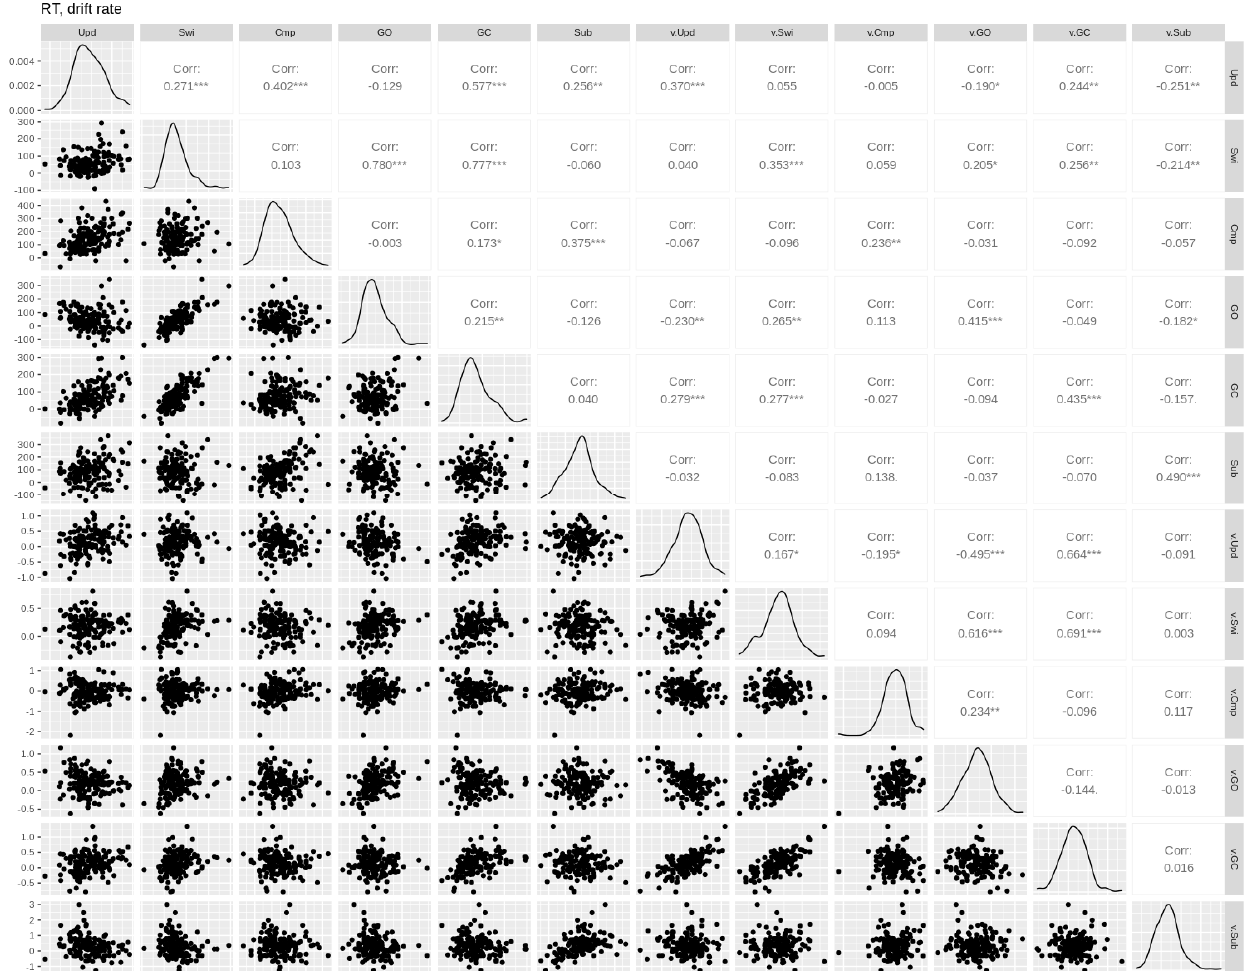
Figure A3. Pairwise Pearson correlations between drift rate and RT cost effects. Empirical effects are shown in the first six columns. Parameter effects are shown in the last six columns (prefixed with the parameter name). Upd = updating, Swi = switching, Cmp = comparison, GO = gate opening, GC = gate closing, Sub = substitution. Asterisks *, **, and *** denote p ‐values of <0.05, <0.01, and <0.001, respectively.